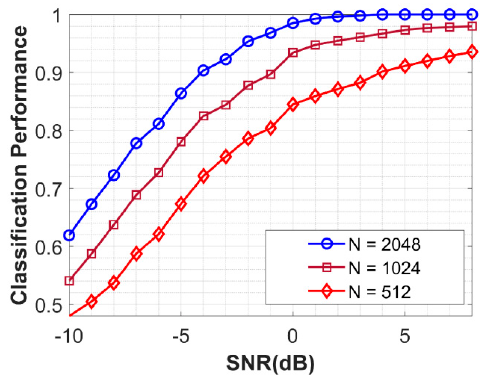
Figure 8. Performance of NSVM with different sampling points.